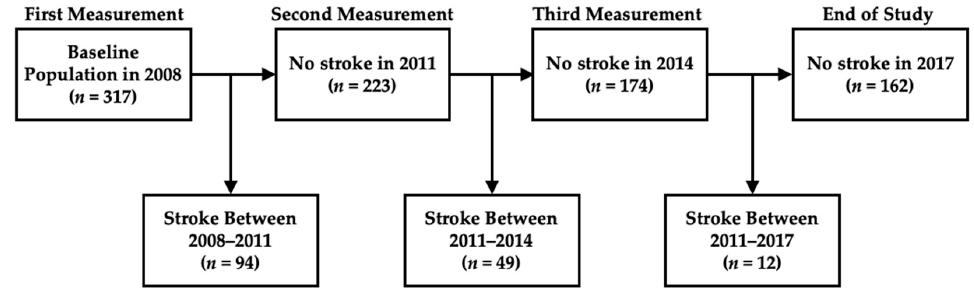
Figure 1. Flowchart of the observation timeline, where n indicates the number of individuals.